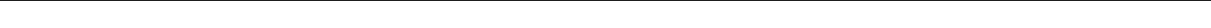
Fig. 6 AMPK-mediated Skp2 S256 phosphorylation and Akt activation promotes cancer progression, predicts poor survival outcome and contributes to resistance of EGFR targeting therapy. a MDA-MB-231 cells with control (shLuc) and AMPK α 1 knockdown were subcutaneously injected into nude mice. Tumor size was measured by the caliper, and the result was showed as means ± SEM. ( n = 5). ** P < 0.01. b MDA-MB-231 cells with stable expression of the indicated pBabe-Skp2 WT, S256A and S256D were subcutaneously injected into nude mice. Tumor size was measured by the caliper, and the result is shown as means + SEM ( n = 5). ** P < 0.01. c pSkp2 (S256) and pAMPK are upregulated in breast cancer patients. Representative images of histological analysis of pSkp2 (S256), pAkt, pAMPK and p27 staining in early (Left panel) and late-stage human breast cancer (Right panel). Scale bar, 200 μ m. d Overexpression of pSkp2 (S256) and pAMPK are detected in advanced stage of breast cancer patient. Box plot represents pSkp2 (S256), pAMPK and pAkt expression in different stages of breast cancer patient. ** P < 0.01. e pAMPK and pAkt expression both correlate with pSkp2 (S256) in breast cancer patients. Scatter plots of pSkp2 (S256) expression vs. pAMPK (Upper panel) and pAkt (Lower panel) expression in breast cancer patient were presented. f Overexpression of pAMPK, pSkp2 and pAkt predicts poor survival outcome of breast cancer patients. Kaplan – Meier plots showed that high expression of pAMPK (Left panel), pSkp2 (S256) (Middle panel) and pAkt (Right panel) signi fi cantly predicted disease-speci fi c survival. p-values are shown in the graphs. g Ge fi tinib-resistant H1975 NSCLC cells with stable expression of the indicated vector, pBabe-Skp2 S256A and S256D were treated with Ge